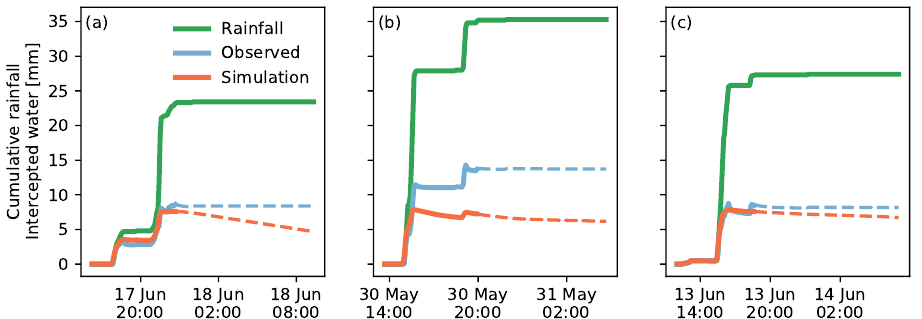
Figure 3. Comparison of observed and predicted interception load for ( a ) event #1 (June 2011), ( b ) event #2 (May 2012), and ( c ) event #3 (June